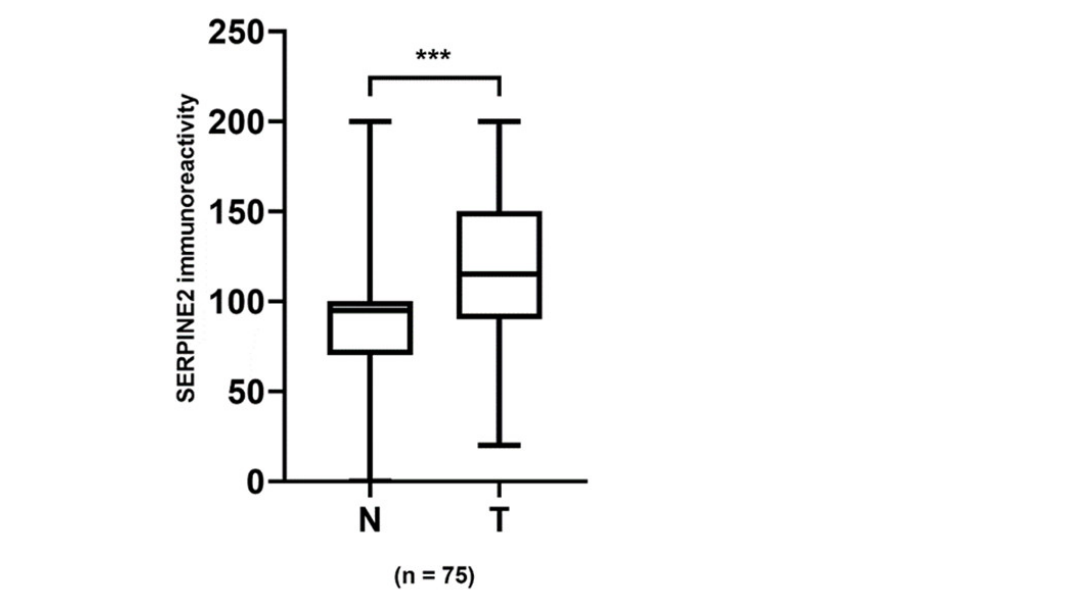
Figure 2. SERPINE2 was upregulated in urothelial carcinoma tissues. Quantification of SERPINE2 immunoexpression in 75 paired urothelial carcinoma specimens and significance determined by the paired t -test. ***, p < 0.001.